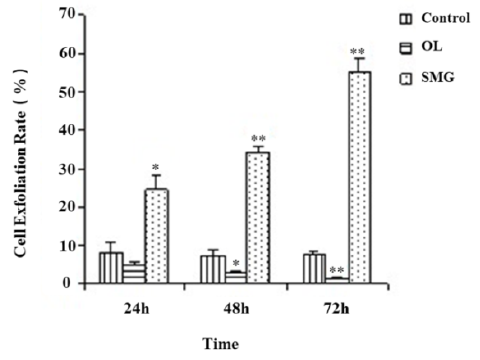
Figure 1. HUVEC cell exfoliation rate after trypsin treatment. * p < 0.05, Significant difference; ** p < 0.01, extremely significant difference. Cell Exfoliation Rate = Exfoliated cells B/ Total Number A ( n = 3).